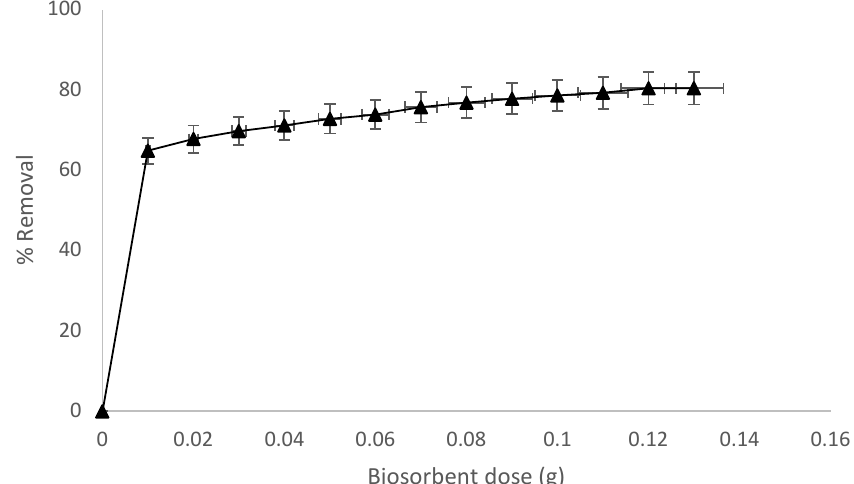
Figure 7. Impact of biosorbent dose.